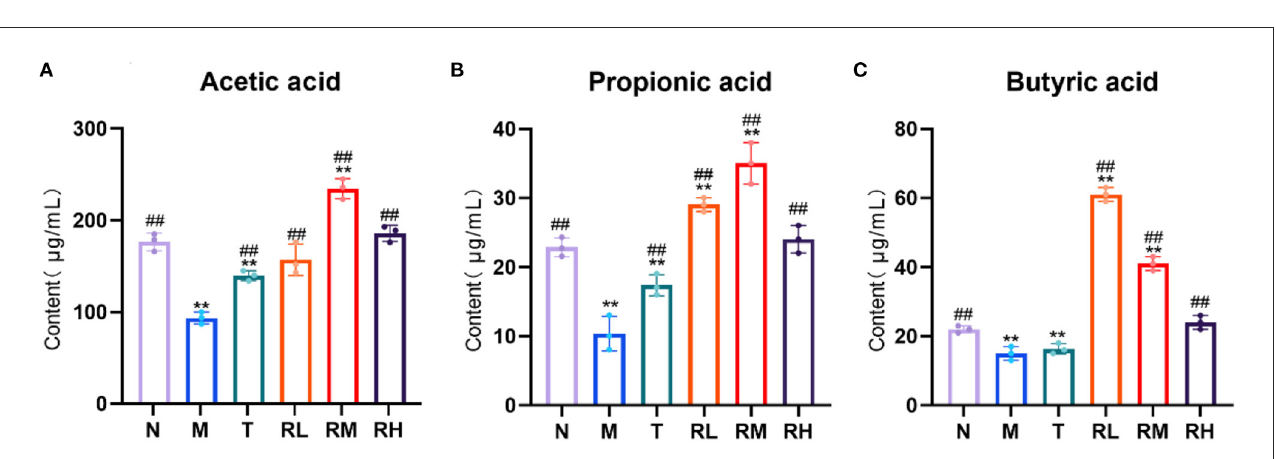
FIGURE6 (A–C) Effect of RGO on SCFAs in mice. Compared with group N: * P < 0.05, ** P < 0.01; compared with group M. # P < 0.05, ## P <